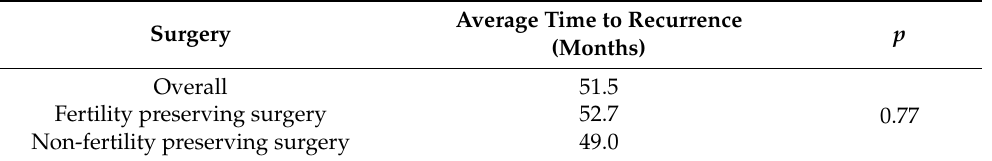
Table 4. Time to recurrence, with recurrence confirmed by tumor